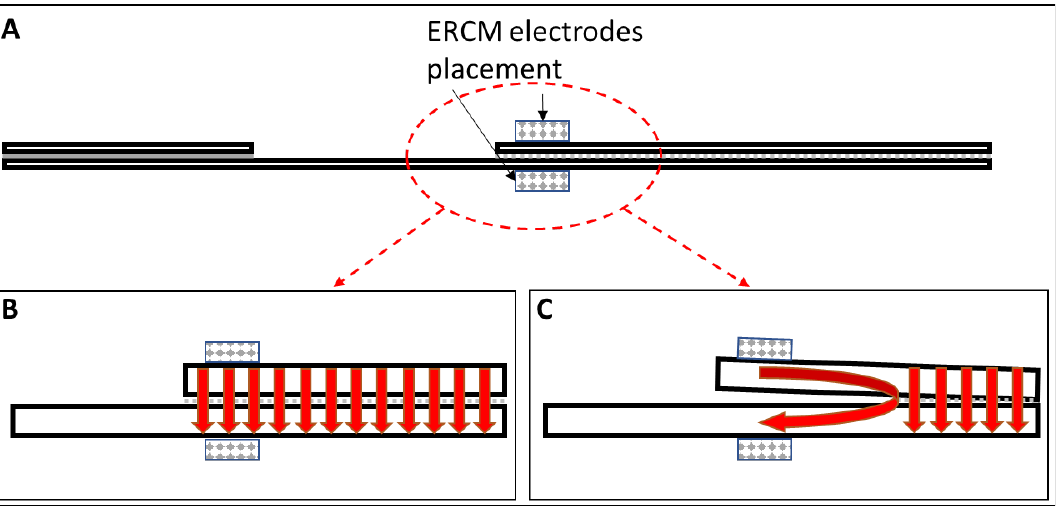
Figure 2. ( A ) Setup of the lap strap specimens for ERCM, ( B ) the current path marked with red arrows before damage, and ( C ) the current path after debonding of the lap from the strap.